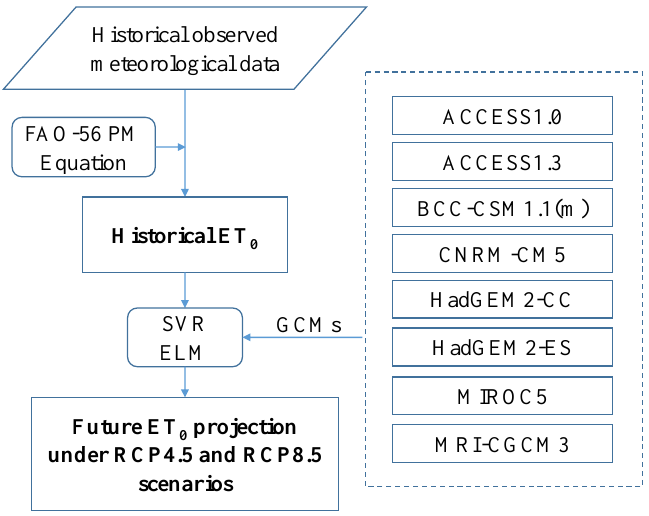
Figure 2. Schematic diagram for the modelling process followed to generate future reference evapotranspiration (ET 0 ) projections.